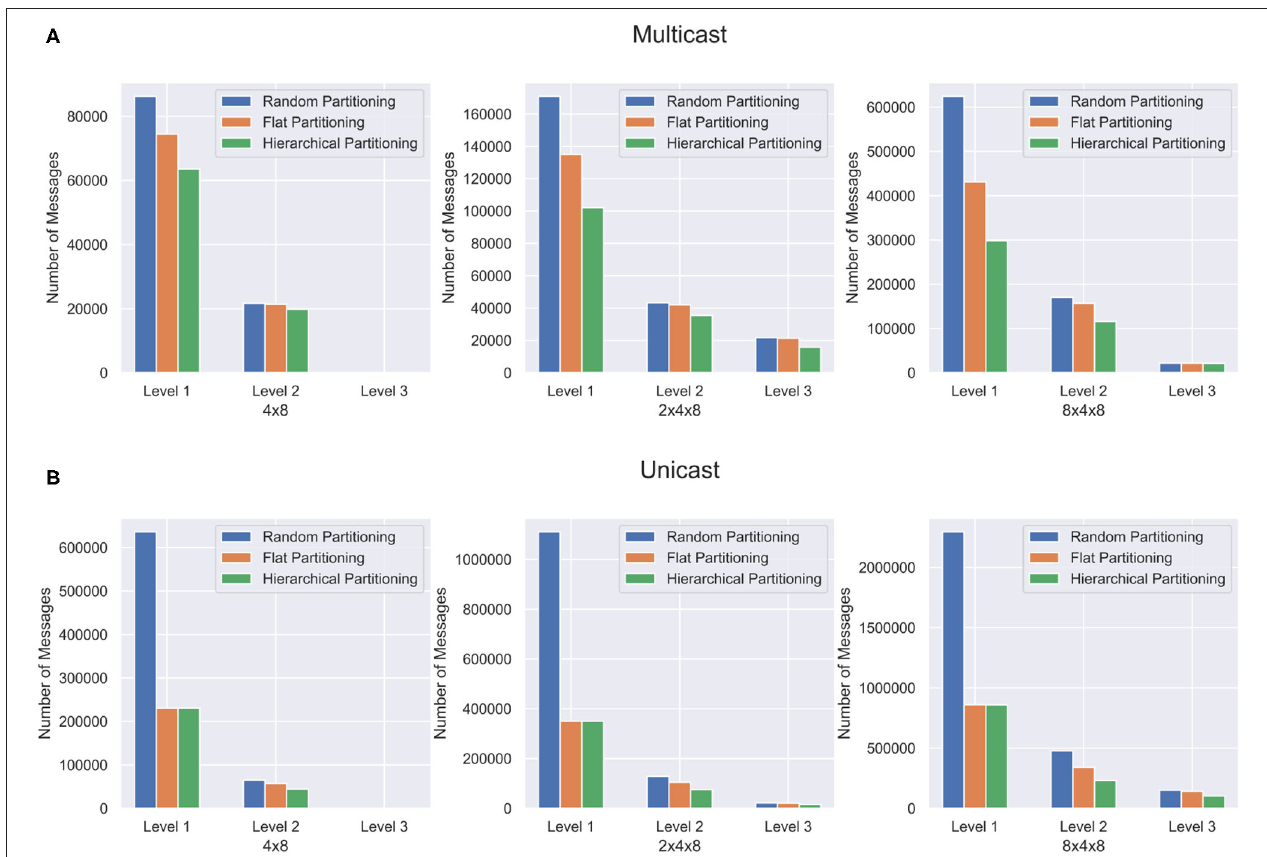
FIGURE 8 | Partitioning results for the fly hemibrain network. The network is partitioned in three different ways, and communication cost reduction is demonstrated using (A) multicast and (B) unicast.